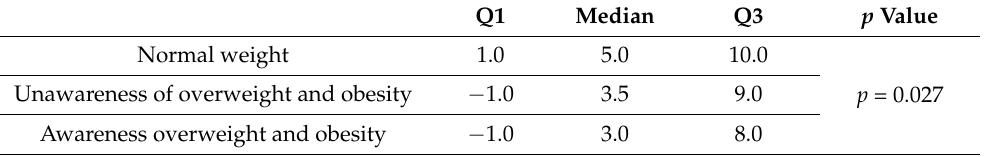
Table 7. Average points scored for consumption of recommended products in the study